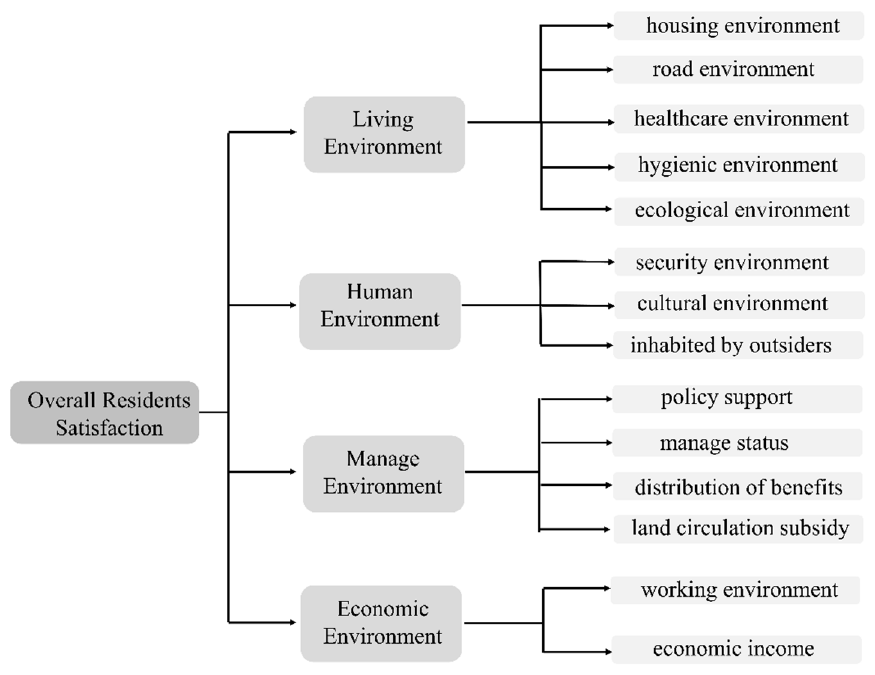
Figure 1. The hierarchical structure of multi-dimensional environment evaluation system.